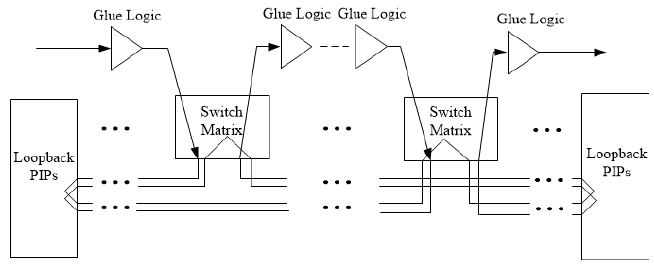
Figure 8. Horizontal hex line cycle with glue logics.